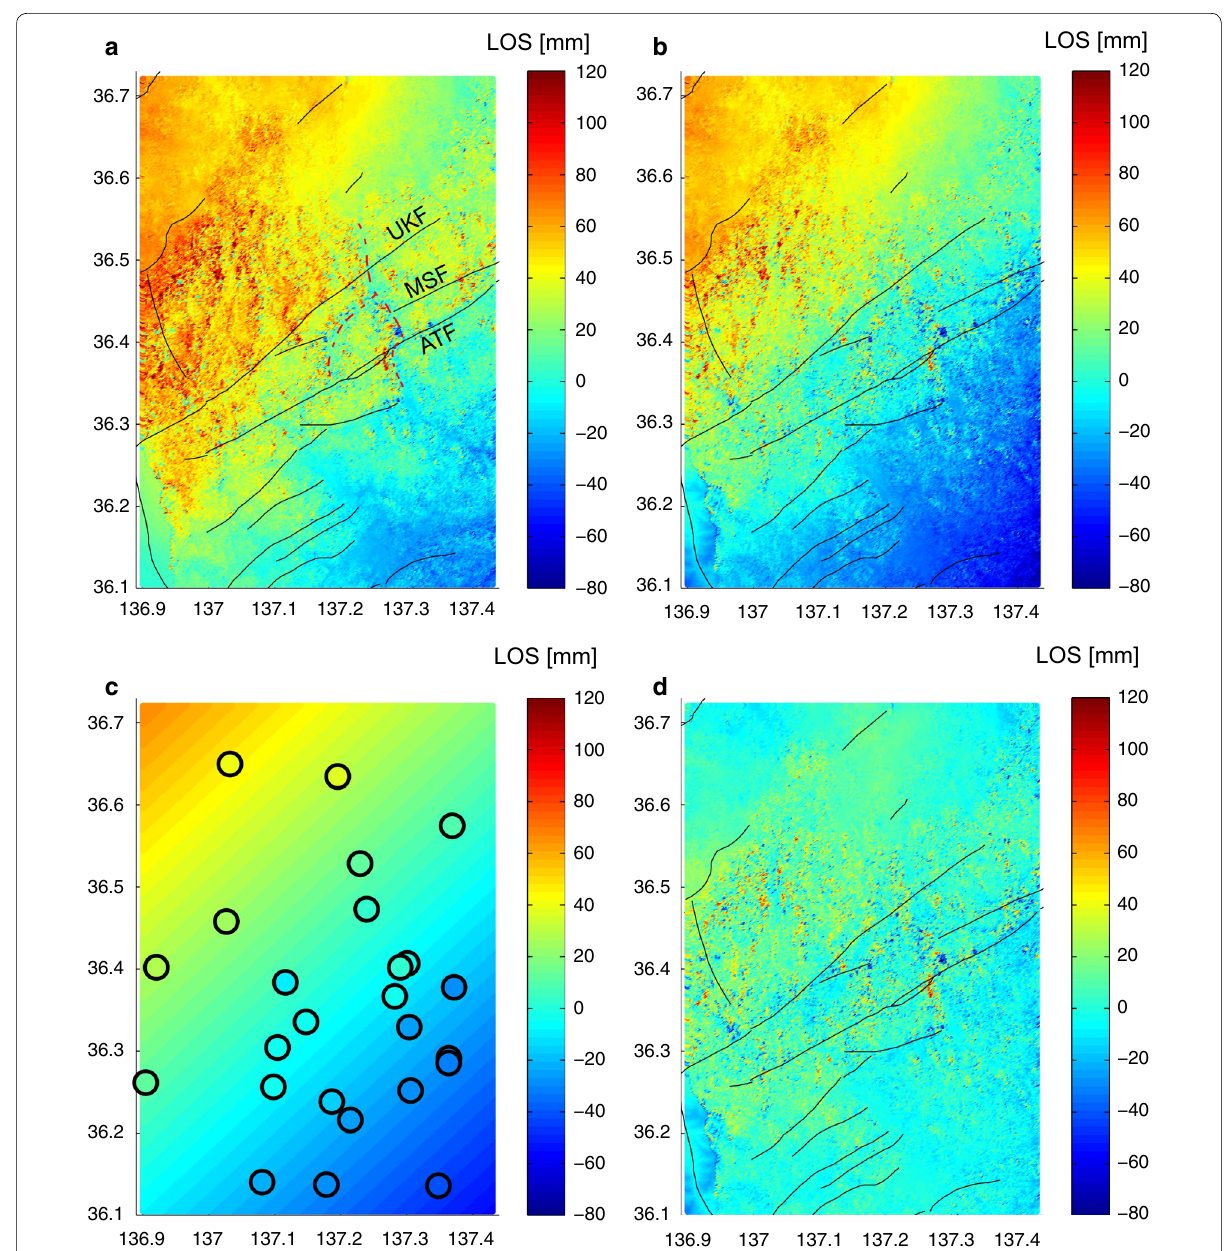
Fig. 5 Interferogram correction for the pair 20071104-20100512 spanning 920 days. a Original interferogram. Red broken lines indicate the river valley cutting through the Atotsugawa fault system. b After removal of height-dependent term. c Bilinear trend removed from b . Colored circles represent the errors included in the interferogram ( d err i in Eq. 2) at the GNSS stations. d After removing the height-dependent term and bilinear trend. Black lines represent active faults. The color scales for a – d are the